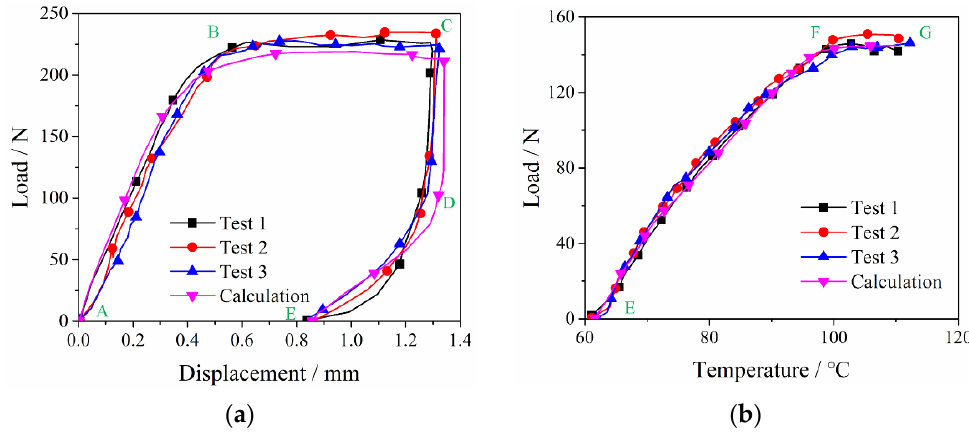
Figure 8. Experimental and simulation results of NiTi alloy corrugated sample: ( a ) Load–displacement curves at room temperature; ( b ) Load–temperature curve at elevated temperature.